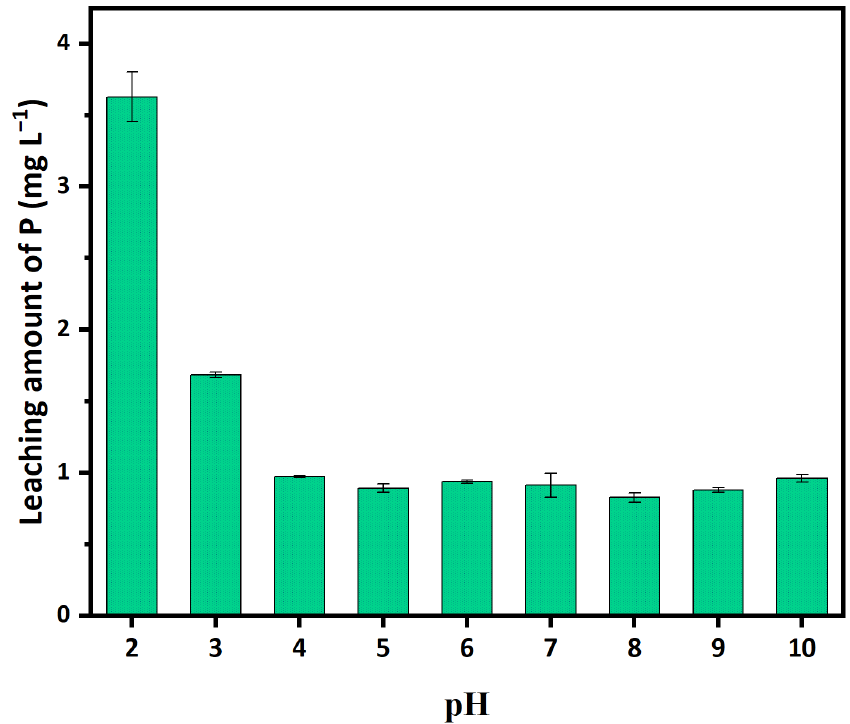
Figure 3. Effects of different pH on the leaching amount of P in BC. (Adsorbent dose: 5 g L − 1 ; P initial concentration: 15 mg L − 1 ; adsorption time: 4 h; temperature: 25 °C; ionic strength: 0.01 M.)